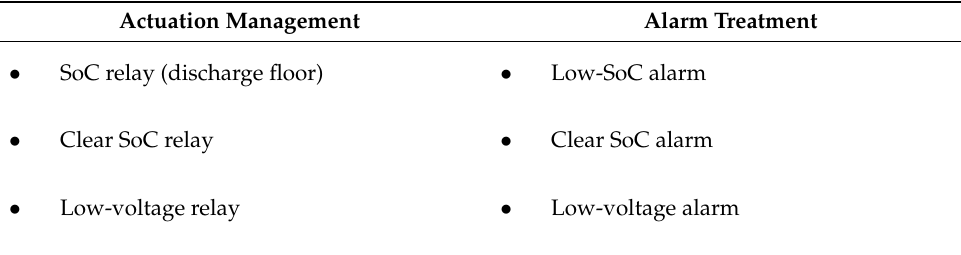
Table 1. BMV-712 relay actuation management and alarm